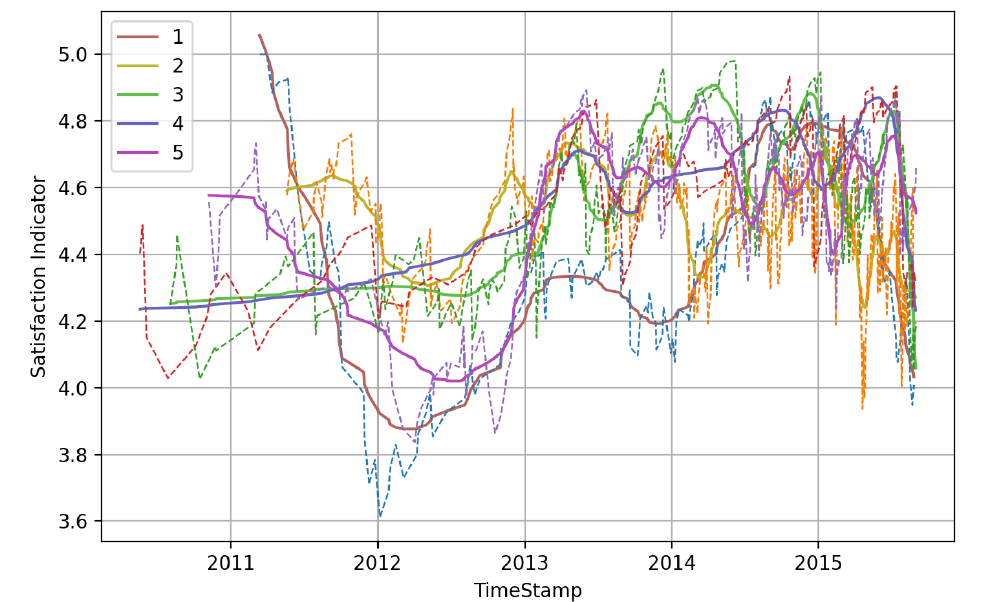
Figure A2. Satisfaction curve of different brands of baby pacifier. The five lines in the picture represent these commodities: 1 refers to the Philips Avent BPA-free contemporary freeflow